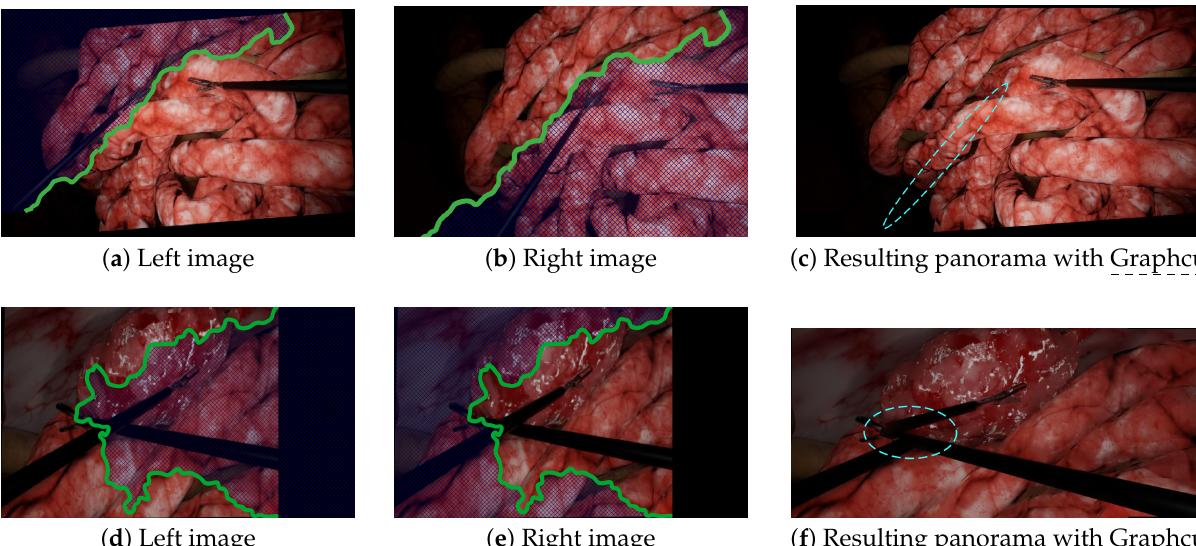
Figure 8. Illustrations of the Graphcut failure to provide reliable image stitching results. Graphcut aligns images by stitching them along a seam (green line). Blue hatching lines represent the areas that disappear during Graphcut alignment. The blue dashed lines show the major issues. ( a – c ) In this scenario, the Graphcut algorithm produced a visually satisfying result, to a non-medical expert, but the disappearance of the left forceps would not be acceptable for clinical application (see